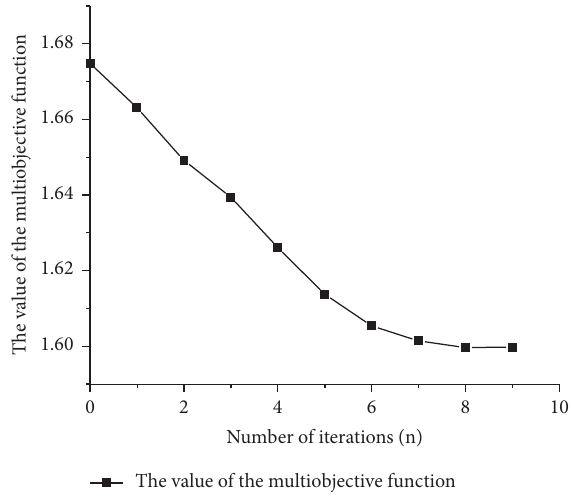
Figure 11: Schematic of the iterative process of multiobjective optimization.